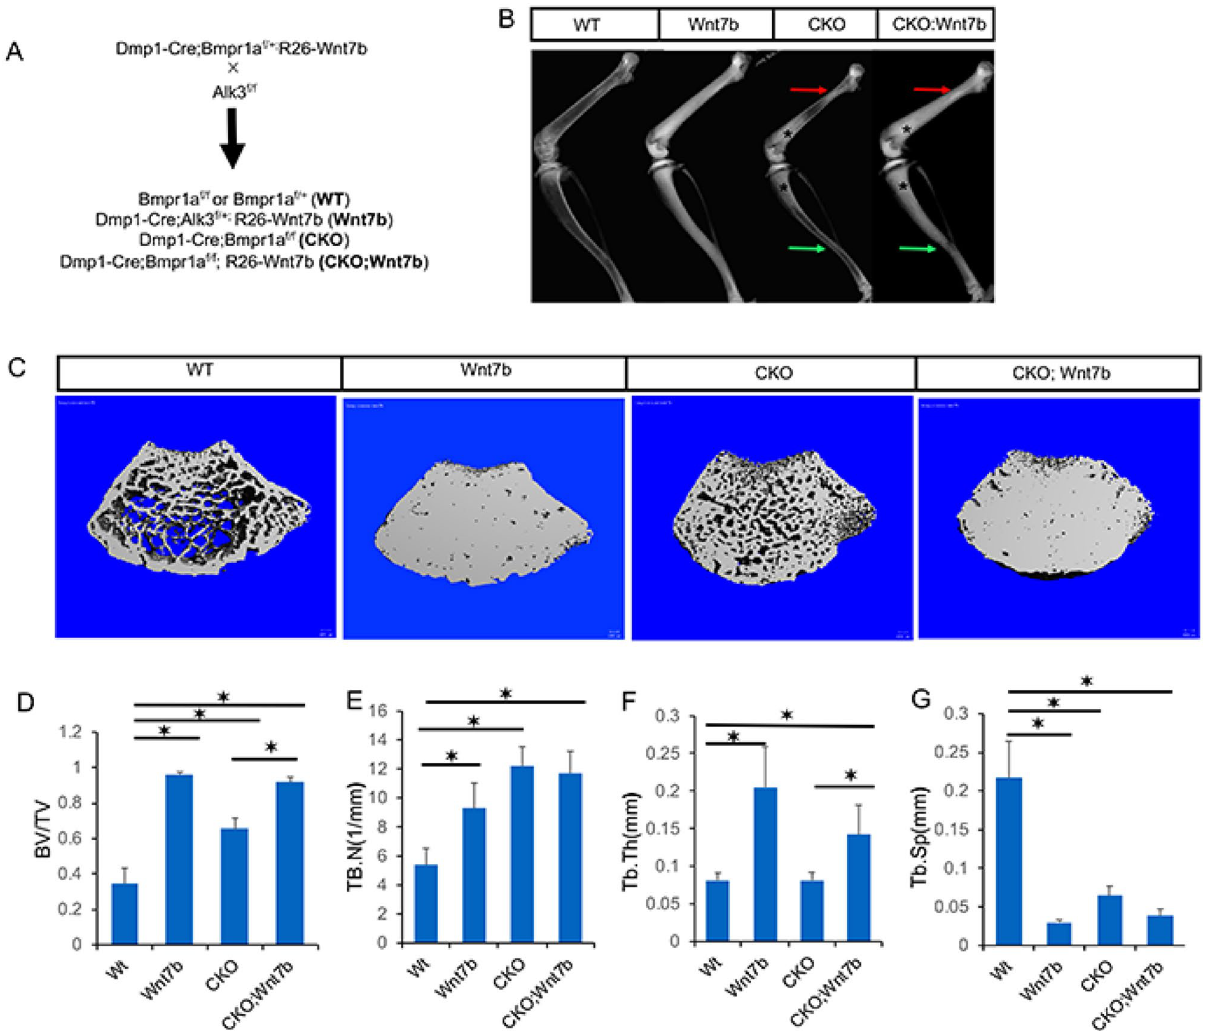
Figure 2. Overexpression of Wnt7b increases trabecular bone mass in both normal and Bmpr1a CKO background. ( A ) Mating scheme. ( B ) Representative X-ray radiography of the hindlimbs from littermate mice at P33. Arrows denote areas of reduced bone size (red: proximal femur; green: tibiofibular junction) in CKO but corrected in CKO; Wnt7b mice. (C) Representative μCT 3D reconstruction images of the distal metaphysis of the femur in littermate mice. ( D – G ) μCT quantification of cancellous bone parameters in the distal metaphysis of the femur. * P < 0.05, two-way ANOVA, n = 6 (4 females, 2